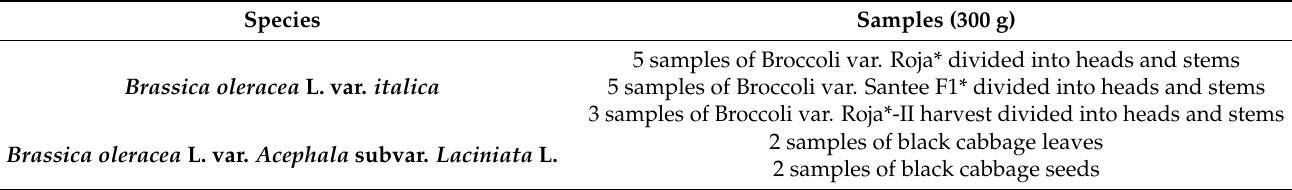
Table 1. Plant materials